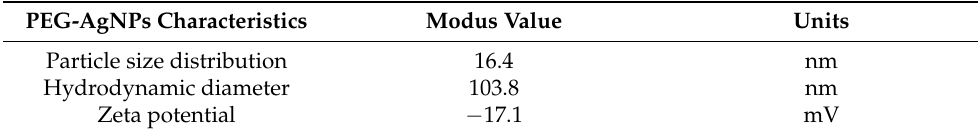
Figure 3. The FTIR spectra ( a ) and anti-bacterial performance ( b ) of the PEG-AgNPs. Figure 3. FTIR spectra ( a ) and anti-bacterial performance ( b ) of the PEG-AgNPs. Table 2. The physical characteristics of the PEG-AgNPs hybrid materials. PEG-AgNPs Characteristics Modus Value Particle size